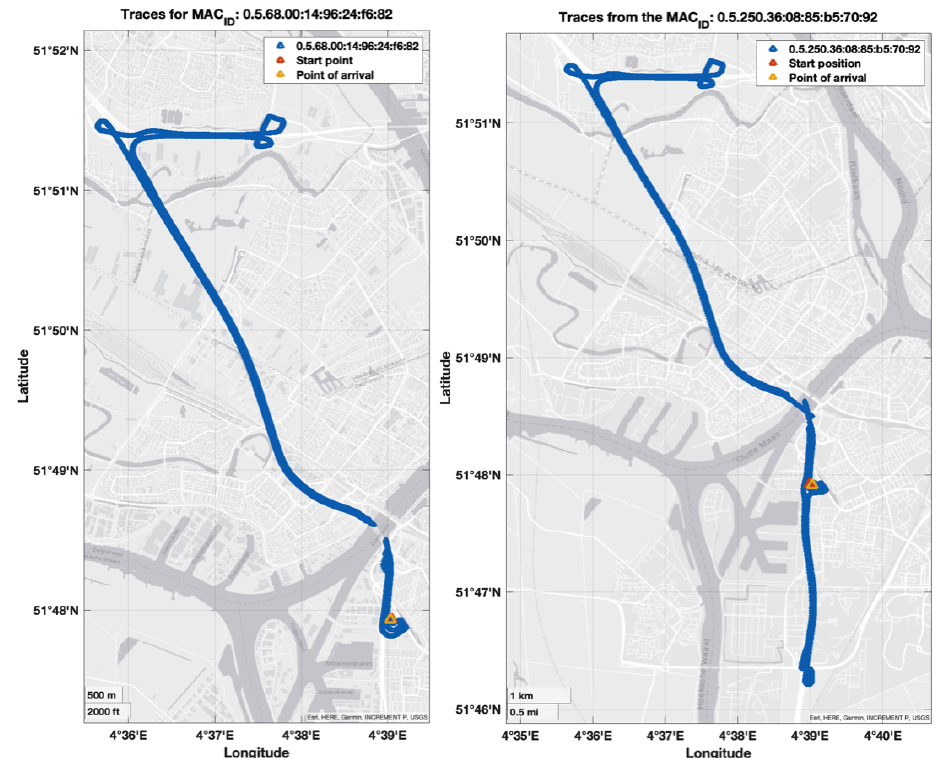
Figure 8. Cluster 1: high